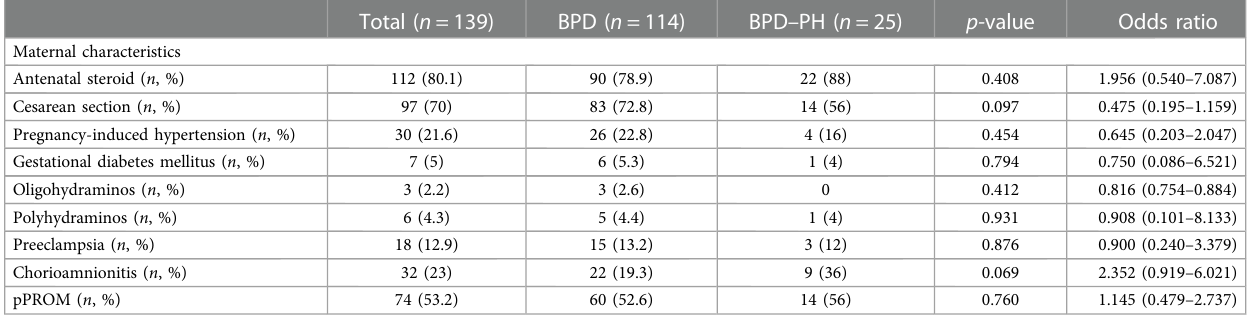
TABLE 1 Maternal characteristics for preterm infants with bronchopulmonary dysplasia with and without pulmonary